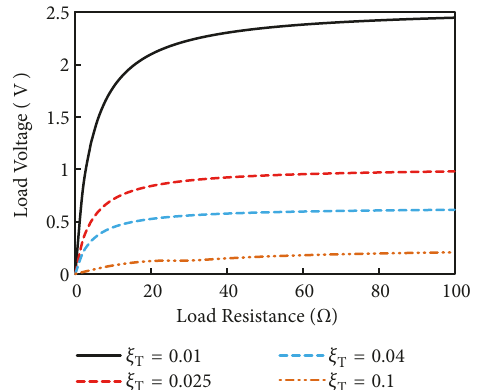
Figure 12: Load voltage and load power at resonance vs. amplitude of pulsating pressure.